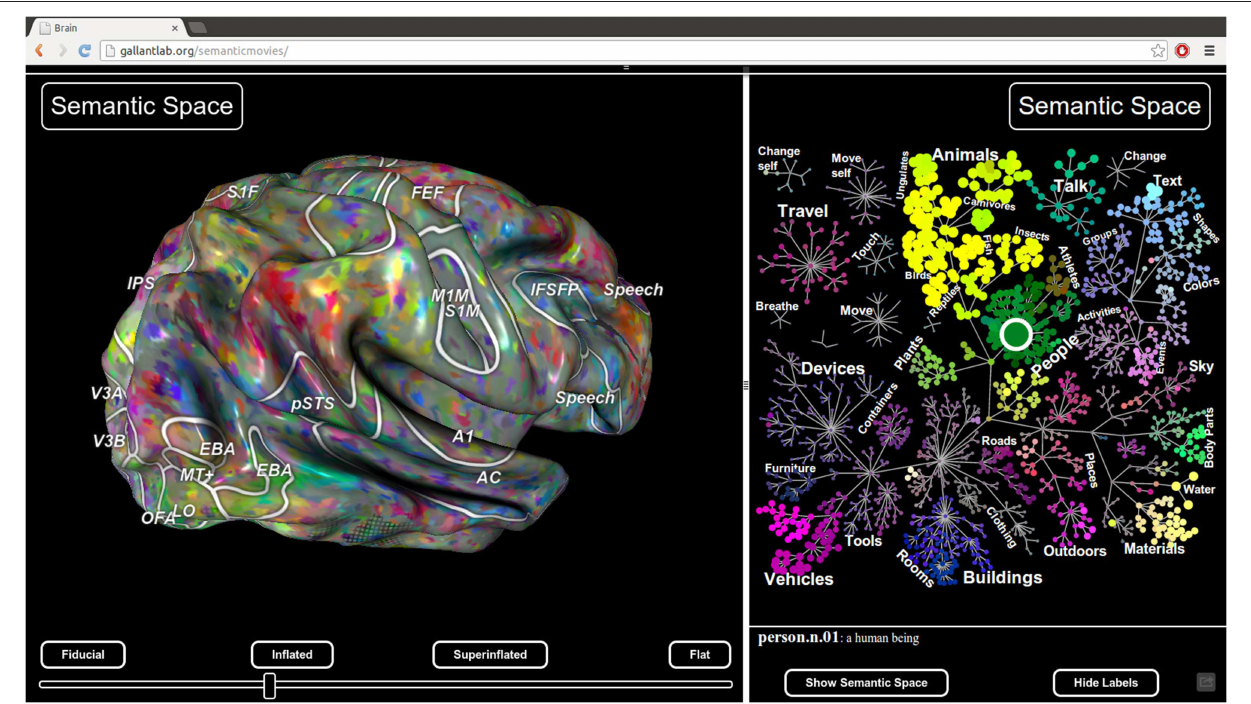
FIGURE 7 | Static view for web presentation. Pycortex uses WebGL to generate a static view that can be hosted on a web site. The static view allows users to share data with colleagues, collaborators, and the public. No additional software needs to be installed. This figure, published with Huth et al. (2012), shows a typical static view. A static plugin written in javascript on the right interacts with the 3D view, allowing dynamic interaction between the plugin and the view.